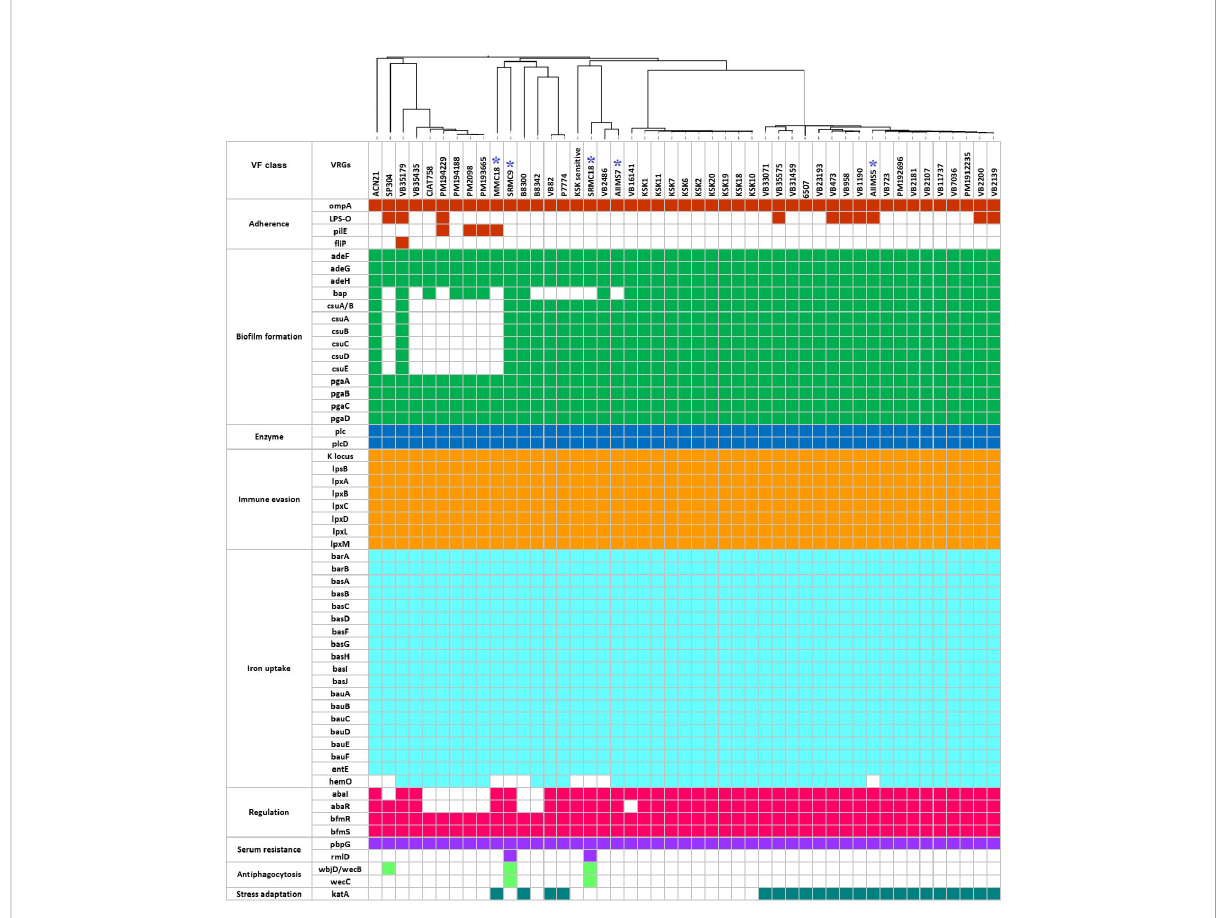
FIGURE 4 The predicted virulome of 47 A . baumannii genomes from India. The colored squares represent presence of VFGs while the empty or colorless squares represent absence of VFGs. The blue asterisks represent fi ve A. baumannii sequenced in this